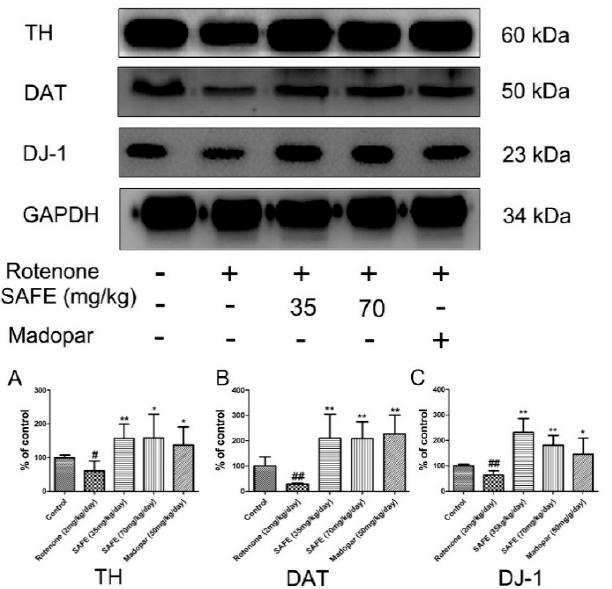
Figure 4. Western blot analysis. After 10 days of rotenone treatment, the levels of TH, DAT and DJ-1 were downregulated. After SAFE treatment, these decreases were reversed. ( A ) TH protein expression levels; ( B ) DAT protein expression levels; ( C ) DJ-1 protein expression levels. The parameters are presented as the mean ± SD, ( # compared to control, # p < 0.05, ## p < 0.01; * compared to rotenone, * p < 0.05, ** p < 0.01) ( n = 4).